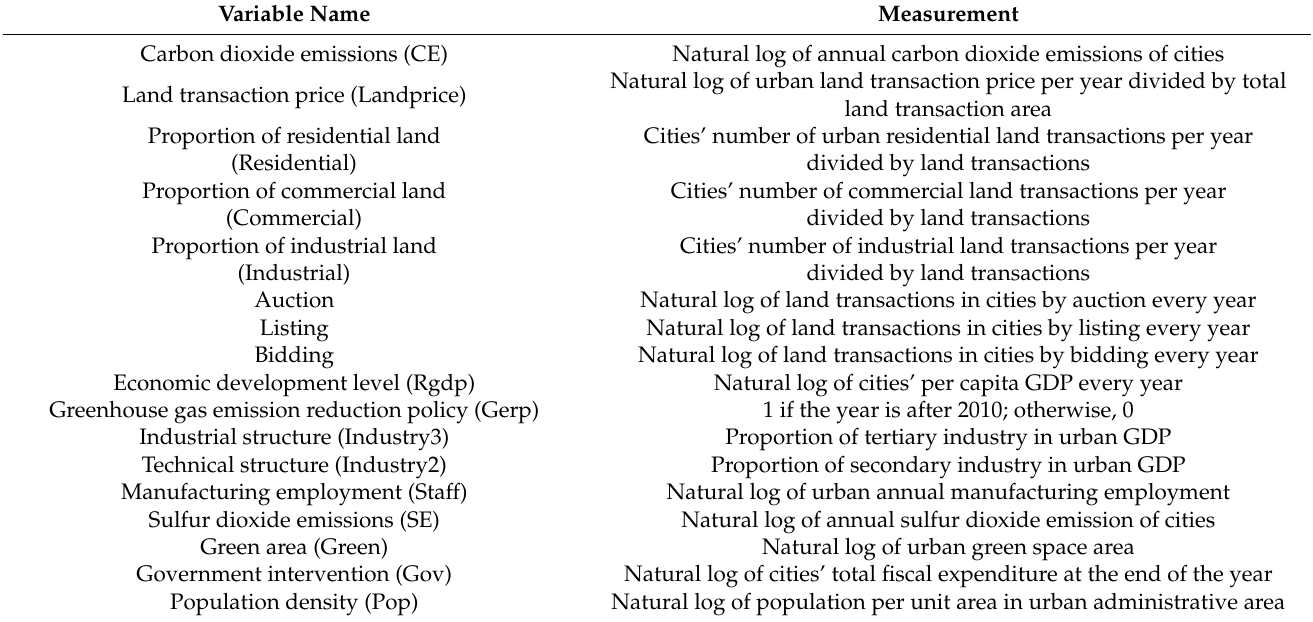
Table 1. List of variables and their